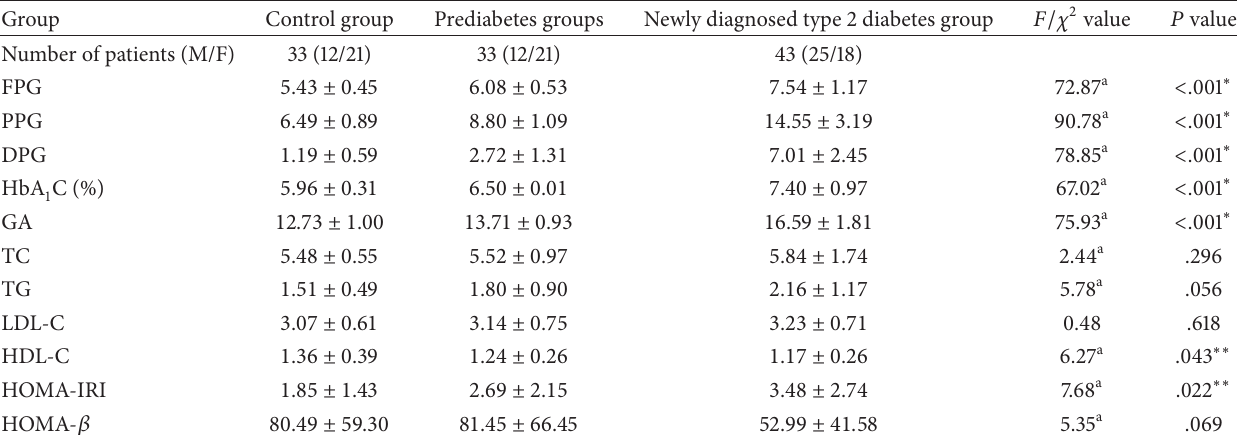
Table 2: Analysis of relative biochemical